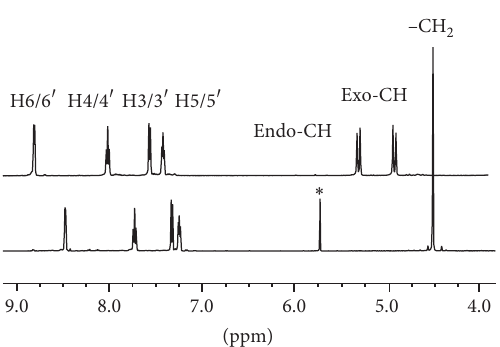
Figure 2: 1 H NMR spectra in DMSO- 𝑑 6 of N(SO 2 pip)dpa (lower) and [Re(CO) 3 (N(SO 2 pip)dpa)] + (upper). ∗ Peak due to trace amounts of CH 2 Cl 2 solvent.